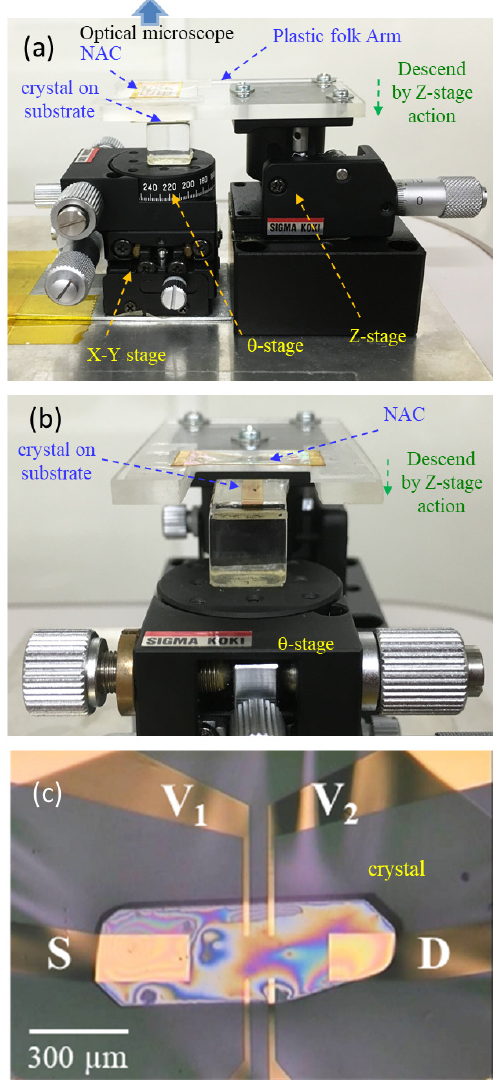
Figure 2. ( a ) Hand-made jig used to laminate the NAC precisely onto the tiny crystal. The crystal on the substrate is placed on the top plate of the X-Y and θ -stage on the left side, and the NAC is settled on the top fork arm of the Z-stage on the right side. ( b ) the same jig being viewed from the θ -stage side. The NAC is mounted between the folk arms as it descends onto the crystal via the action of the Z-stage. ( c ) Optical micrograph of the NAC after adhesion to the organic charge transfer complex. The crystal is shown at the center, and six patterned electrodes are contacting the